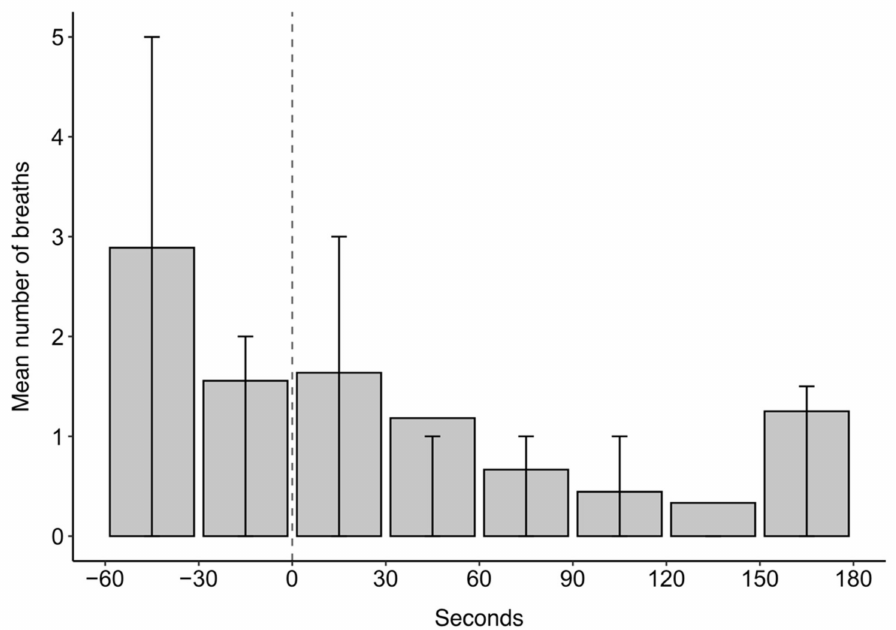
Figure 7. The mean number of breaths in 30 s intervals for 60 s before and 180 s after midazolam administration at time 0 s for 11 trials across four grey seals. Error bars represent the upper (75th percentile) and lower (25th percentile) quartile range of the